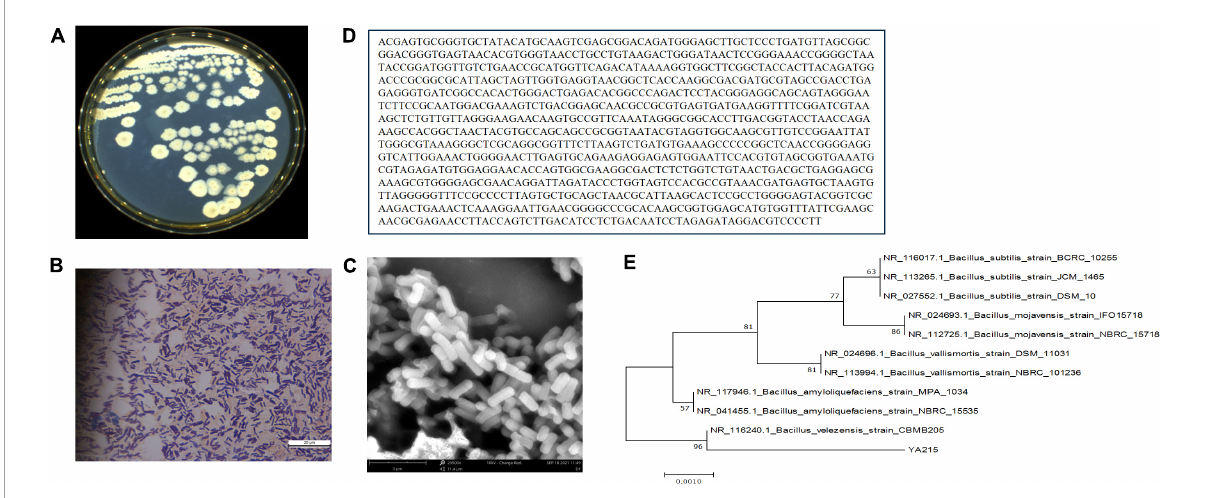
FIGURE1 Identification of the YA215 strain. (A) Colonial morphology of the YA215 strain. (B) Gram staining of the YA215 strain. (C) Electron microscopic picture of the YA215 strain. (D) Sequence of the 16S DNA gene of the YA215 strain. (E) Neighbor-joining phylogenetic tree of the YA215